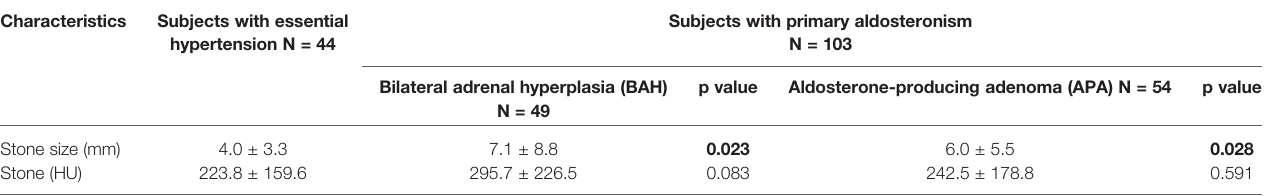
TABLE 3 | The size and Houns fi eld unit of the stone comparing essential hypertension with bilateral adrenal hyperplasia and aldosterone-producing adenoma. Characteristics